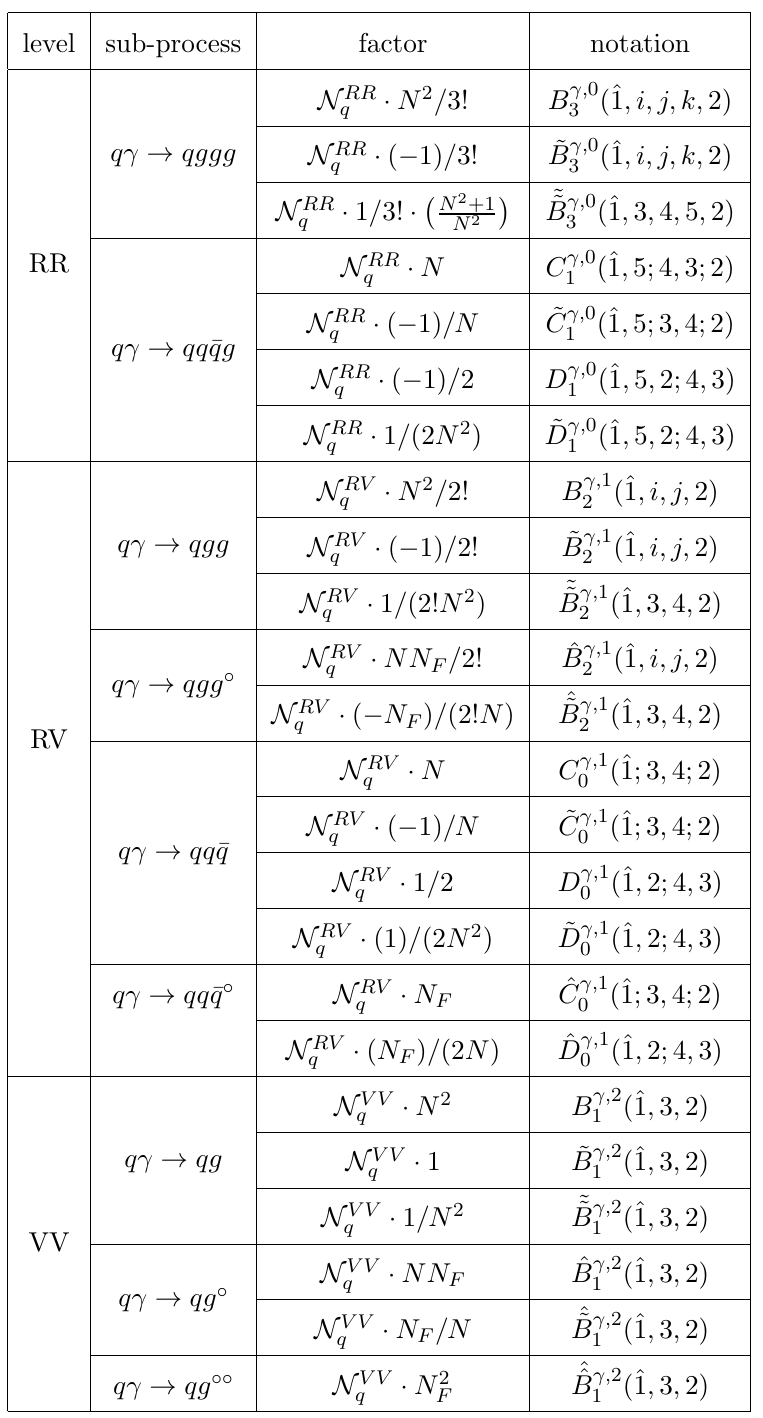
Table 4 . Summary of the quark-channel partonic sub-processes and colour factors for the NNLO calculation and the notation used for the colour-stripped squared matrix elements. Non-numeric arguments denote summation over permutations of partons, e.g. B (cid:13); 0 the six permutations of the labels f i; j; k g 2 P (3 ; 4 ; 5). The lepton momentum labels are suppressed. Each (cid:14) denotes a closed quark